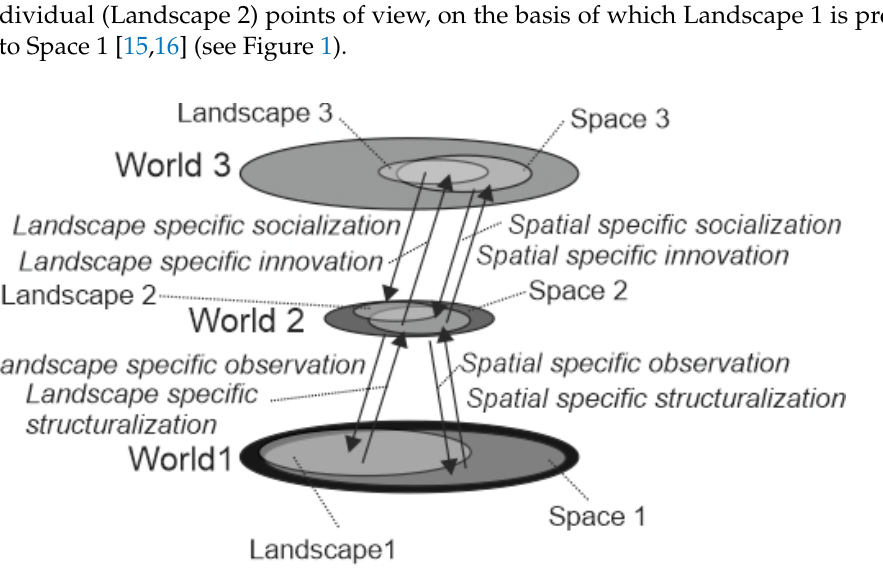
Figure 1. Visualization of the relationship of the three worlds, spaces, and landscapes to each other (own representation).